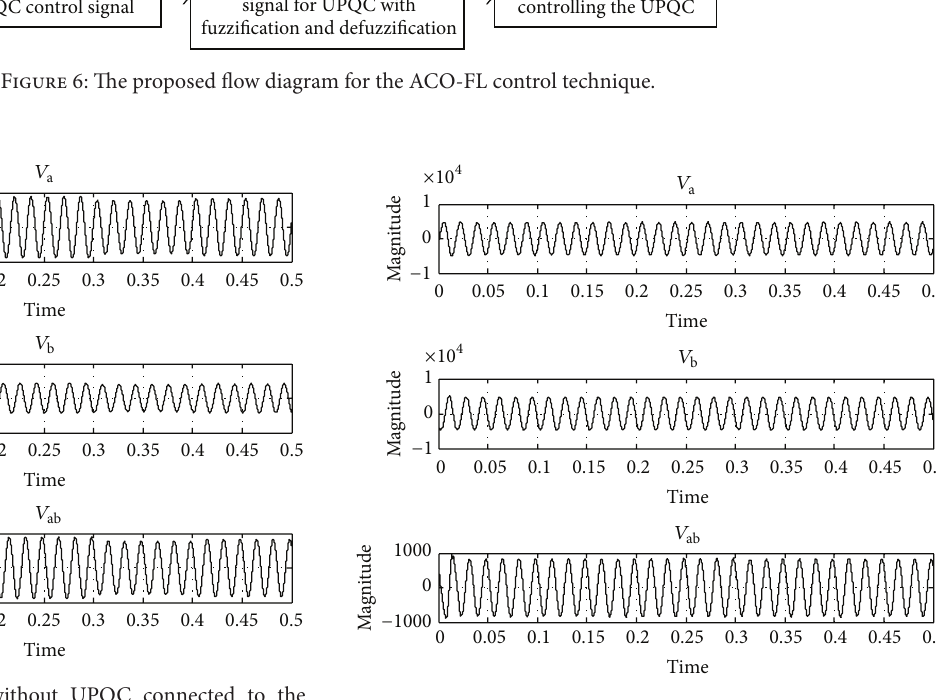
Figure 8: Output waveform with UPQC connected to the system controlled by PI controller. Table 3: Total harmonic distortion for the proposed